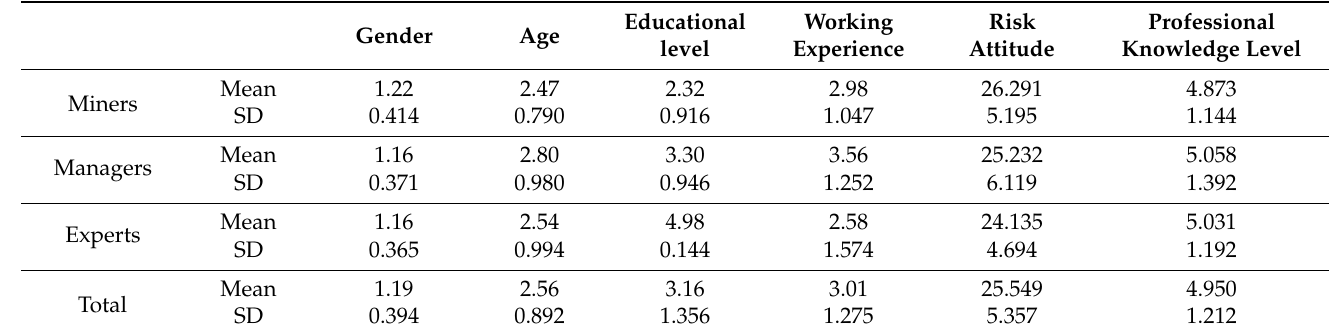
Table 3. Characteristics of different groups of respondents.